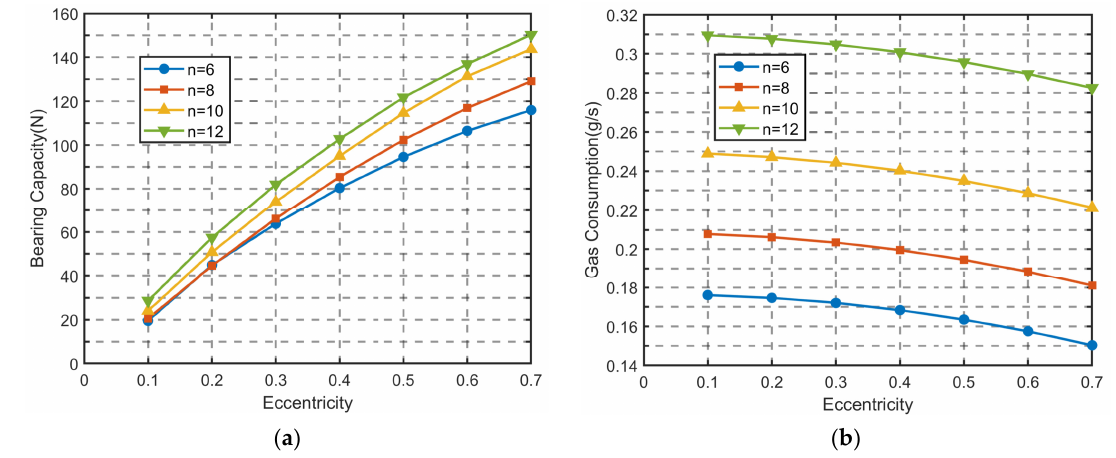
Figure 9. Influence of the number of orifices on ( a ) bearing capacity and ( b ) gas consumption.